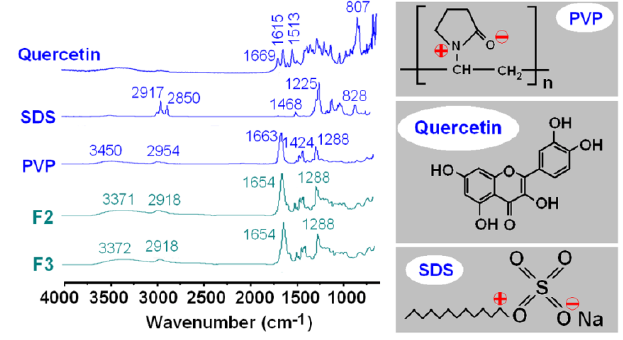
Figure 6. Compatibility investigation: attenuated total reflectance-Fourier transform infrared (ATR-FTIR) spectra of the components (quercetin, PVP and SDS) and their electrospun core-sheath nanofibres, F2 and